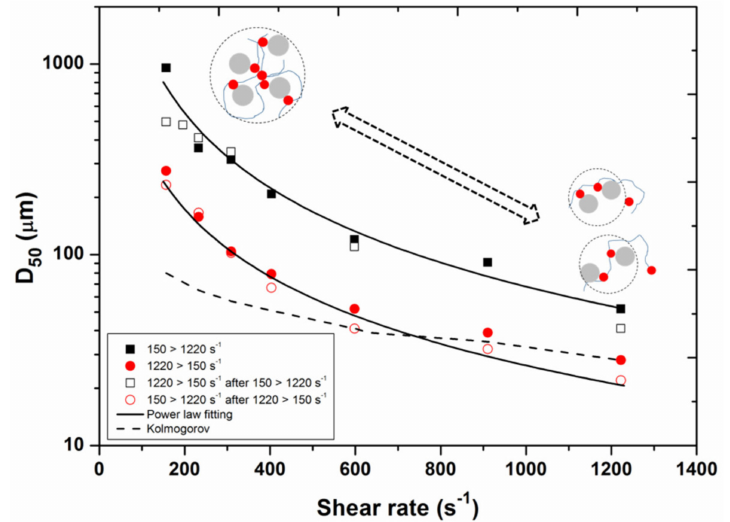
Figure 7. Variation of equilibrium (steady state) floc size (D 50 ) as a function of shear rate for clay concentration of 0.7 g / L with 0.5 mg / g of the anionic flocculant. The red circles represent flocs initially grown at a higher shear rate and the black squares denote flocs initially grown at a lower shear rate. The filled symbols indicate flocs created at the onset of experiments whereas the open symbols indicate flocs already experienced shearing action. The dashed line represents the Kolmogorov length